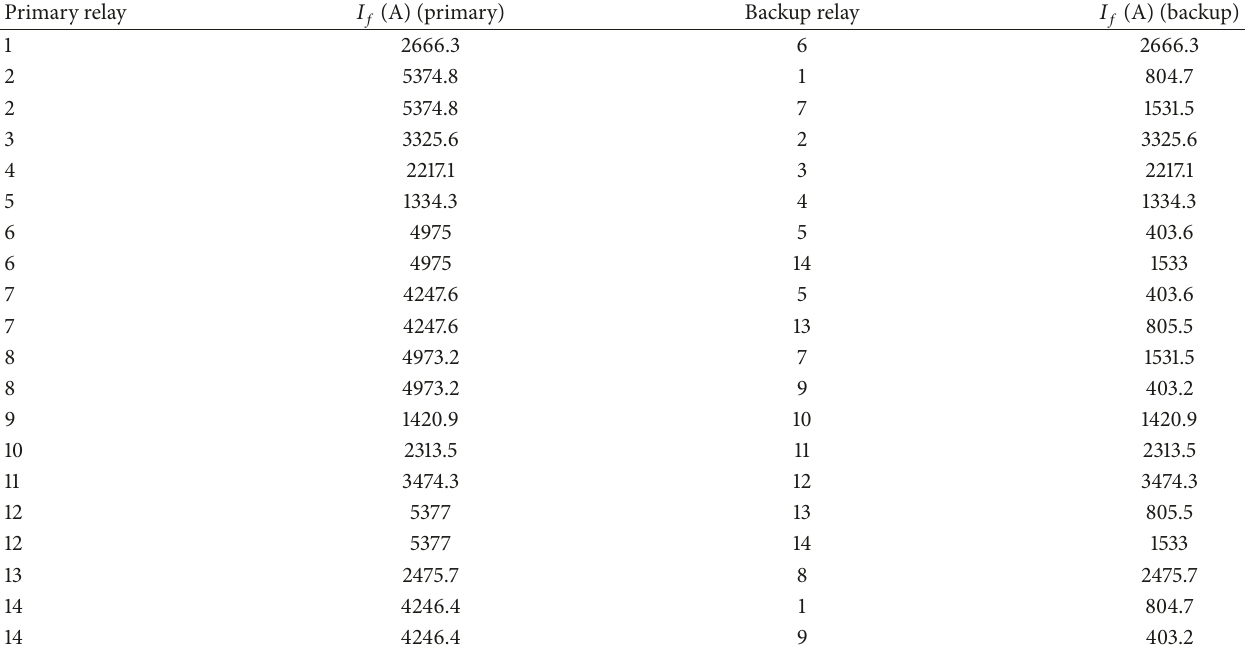
Table 13: Primary/backup relays and fault currents for the 8-bus test system.